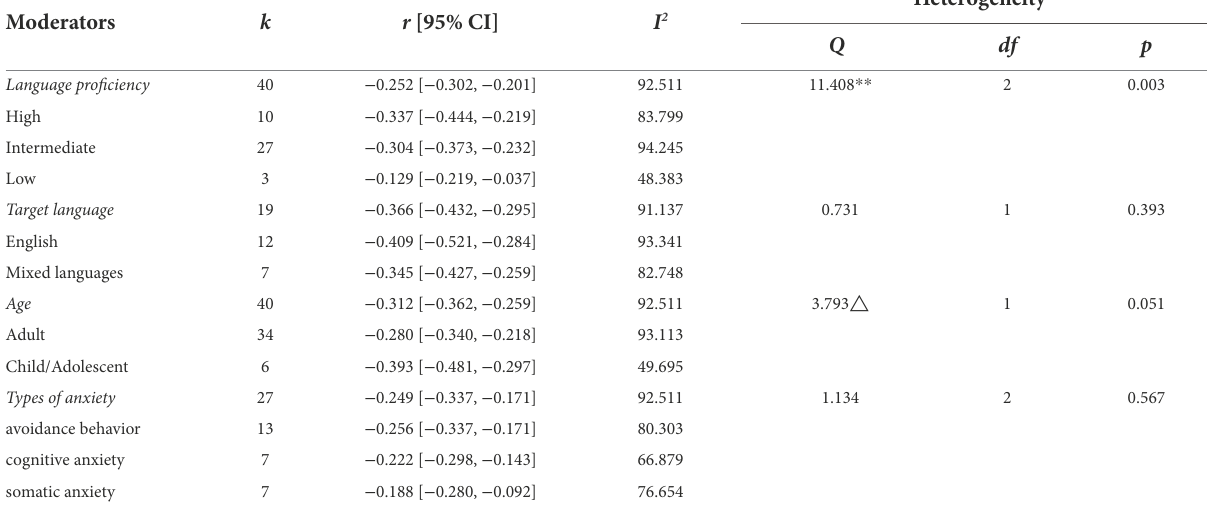
TABLE 3 Overall average correlation and publication bias test for the high-evidence correlates. TABLE 4 Moderator analyses for the foreign language writing anxiety–writing performance correlation.